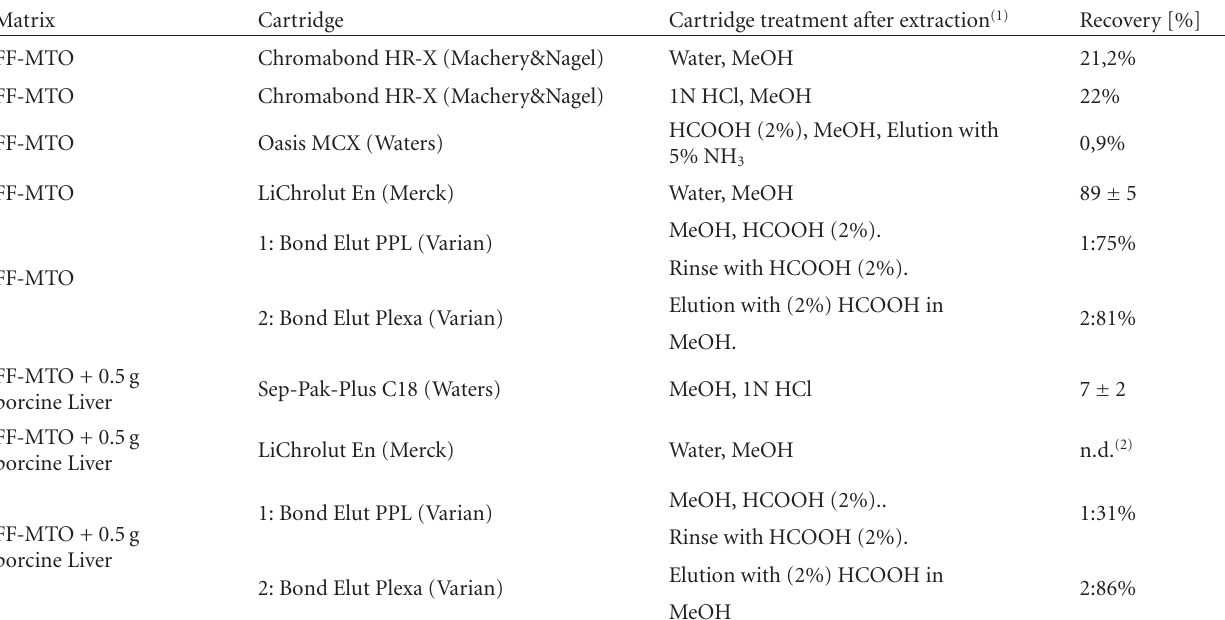
Figure 3: Flow chart of the whole method how to determine MTO in tissue: flow chart of the whole method how to determine MTO in tissue. Table 4: Recovery of MTO after extraction of di ff erent matrices using di ff erent cartridges. Results vary extraordinarily, FF-bound MTO in liver tissue requires special solid